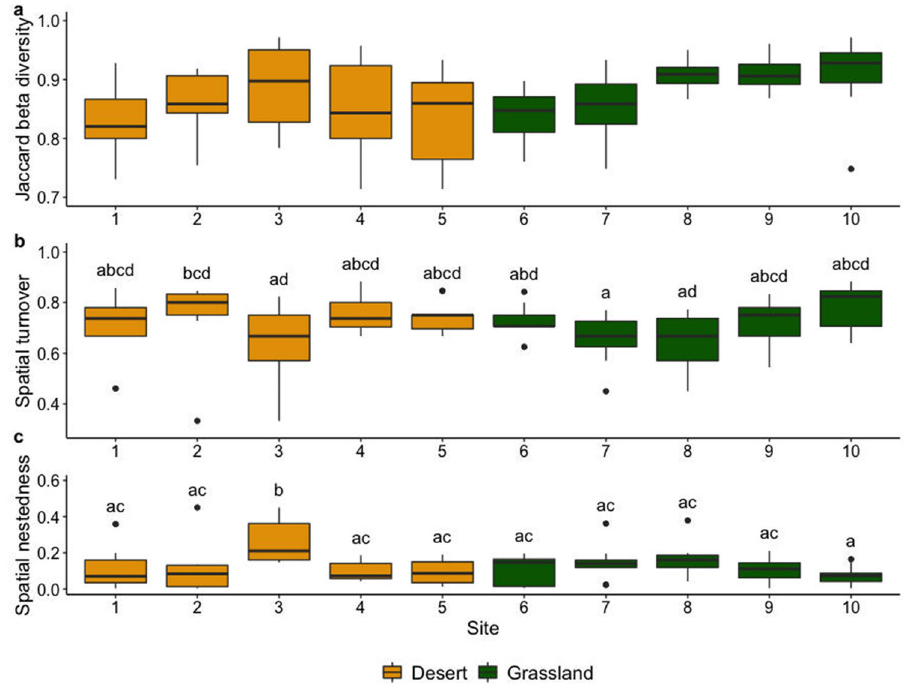
Figure 5. Mean pair-wise ( a ) Jaccard beta diversity, ( b ) spatial turnover, ( c ) spatial nestedness of the ten study sites. Diversity metrics were compared with Wilcoxon test based on the average diversity measures of each site. Different letters show significant differences between sites.